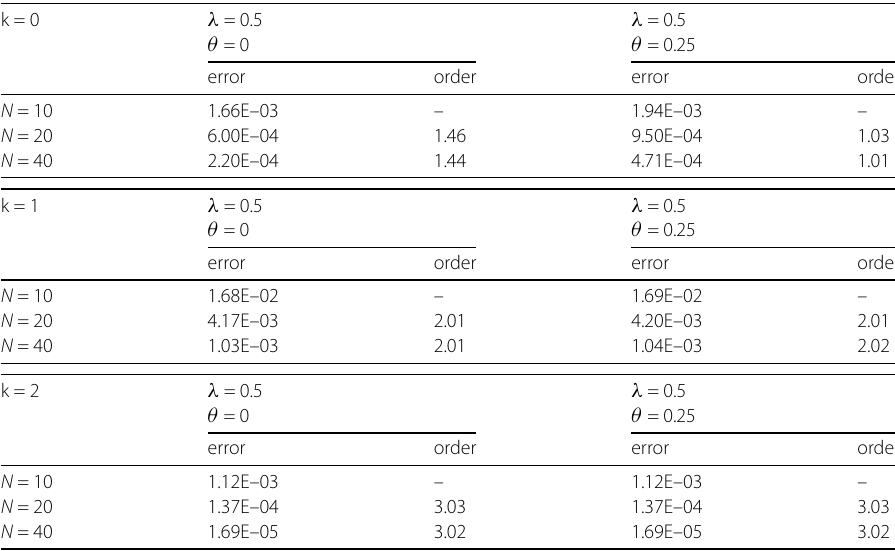
Table 4 The L ∞ error estimates when T = 0.001 and ε =